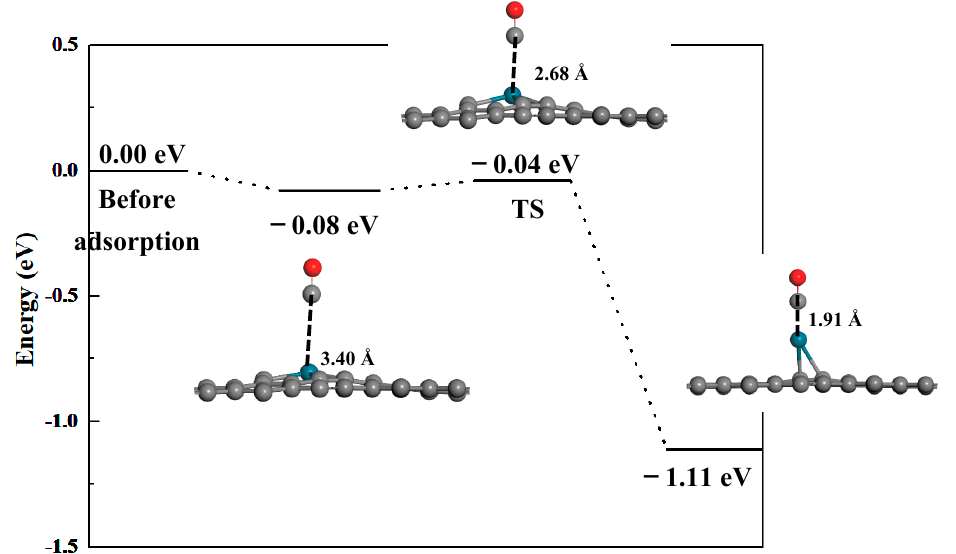
Figure 8. Transition state of CO adsorption on Pd-graphyne.